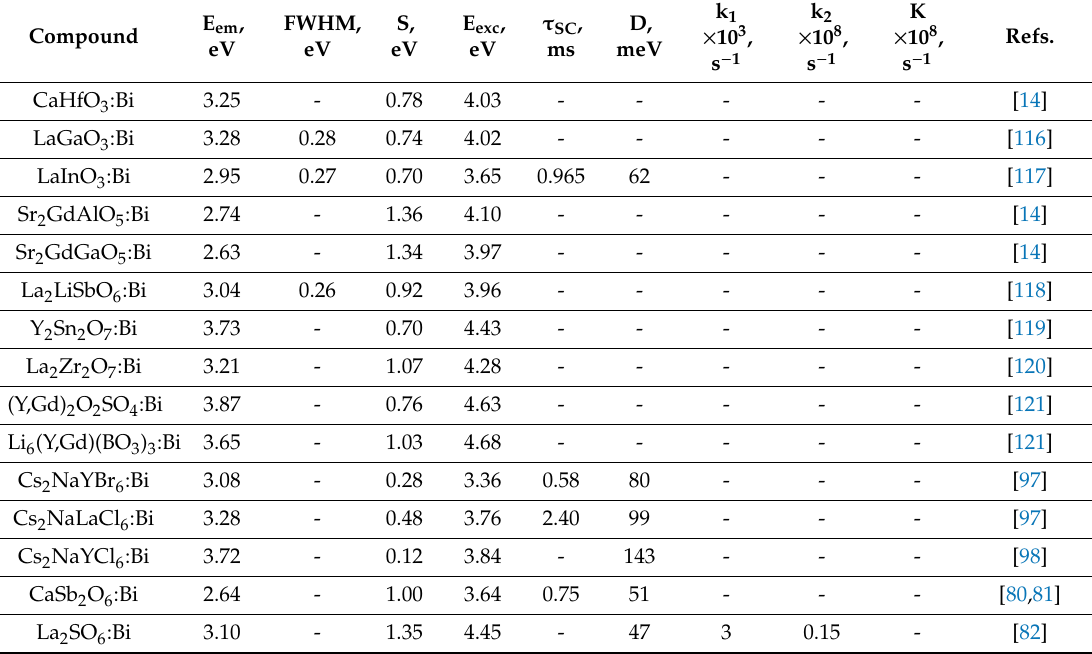
The small Stokes shifts of the UV emission are reported also for NaGdO 2 :Bi (S = 0.6 eV), LiScO 2 :Bi